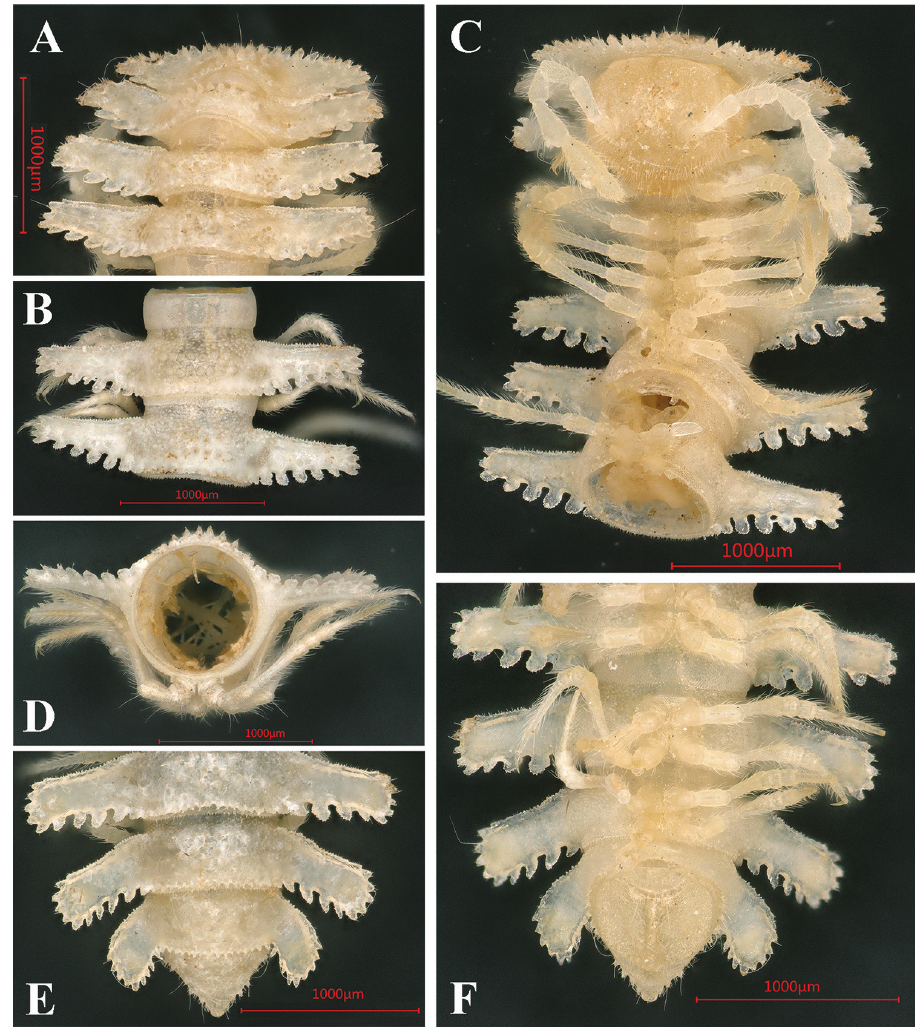
Figure 8. Trichopeltis reflexus sp. n., ♂ paratype. A collum, segments 2–4, dorsal view B segments 8–9, dorsal view C head and segments 1–7, ventral view D cross-section of segment 9, caudal view E–F segments 17 or 16–19 and telson, dorsal and ventral views,